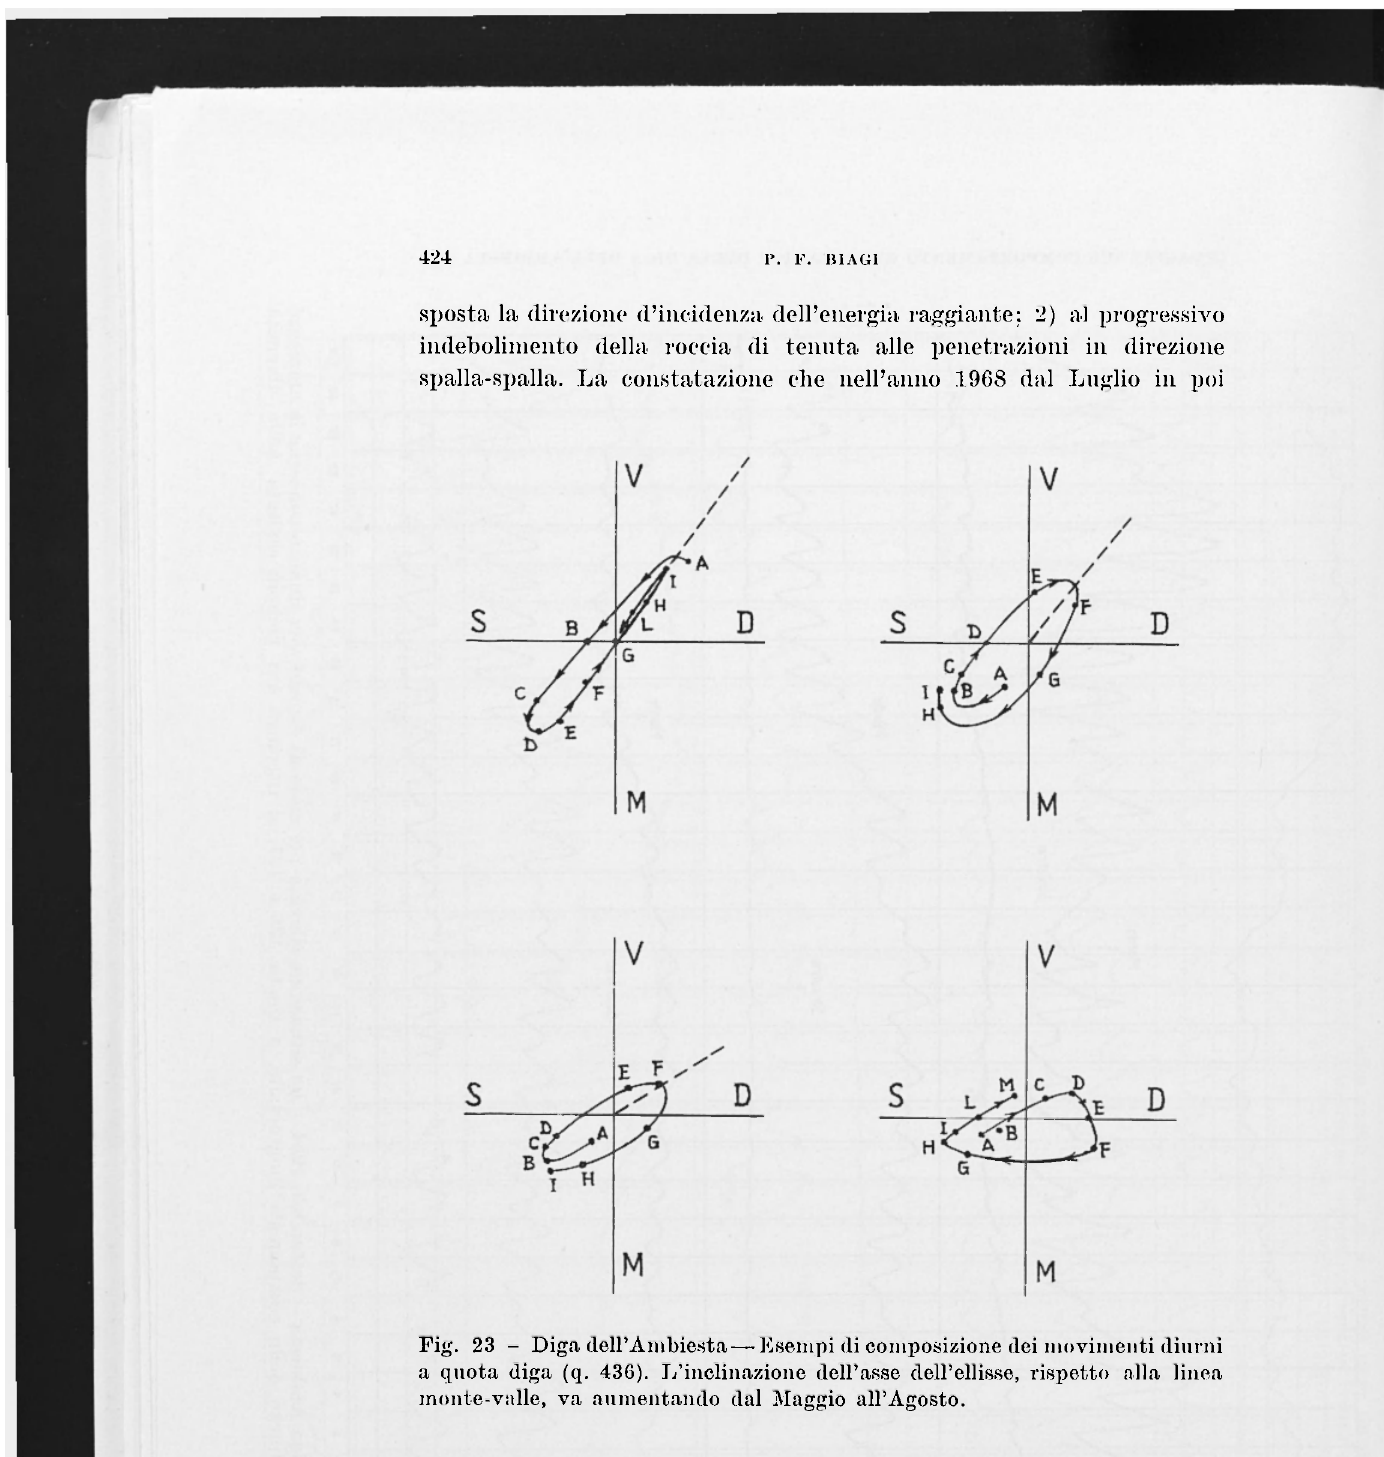
Fig. 23 - Diga dell'Ambiesta— Esempi di composizione dei movimenti diurni a quota diga (q. 436). L'inclinazione dell'asse dell'ellisse, rispetto alla linea monte-valle, va aumentando dal Maggio